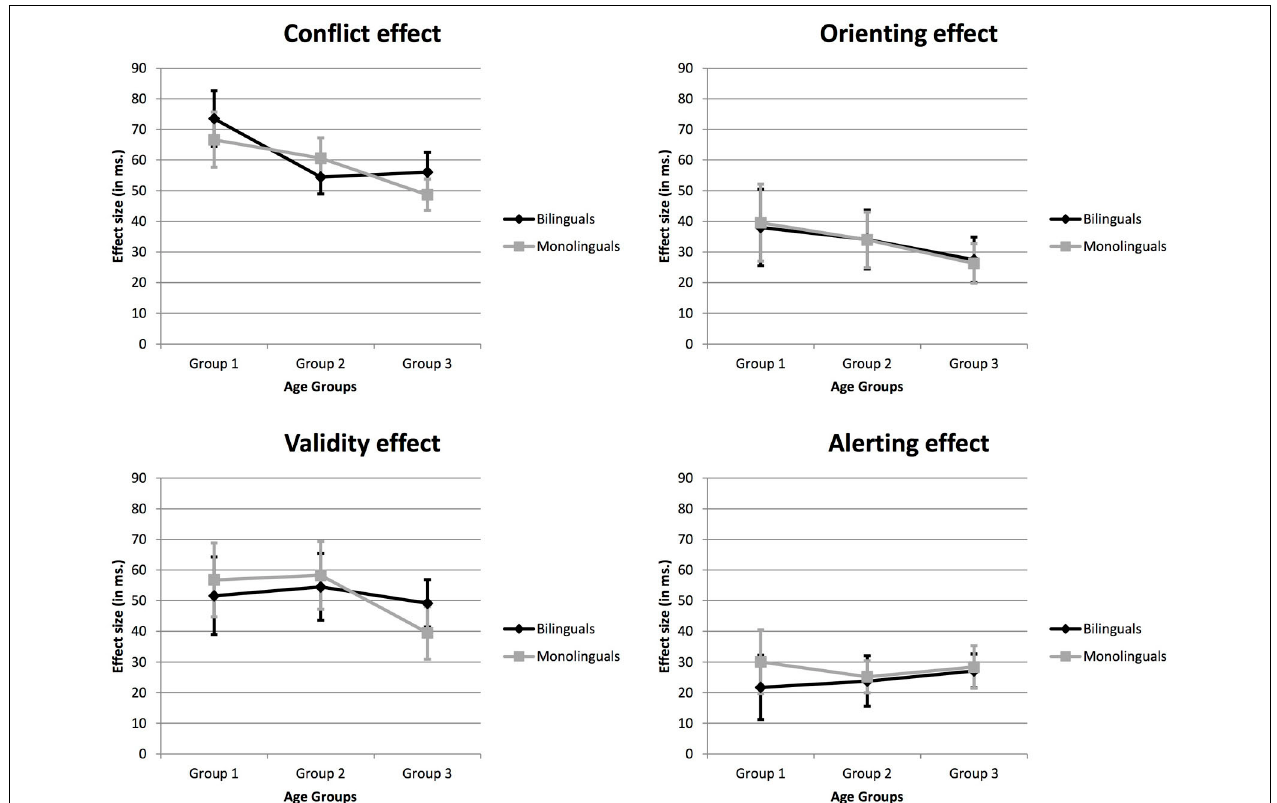
FIGURE 2 | The four indexes, representing the attentional networks, across age groups and language groups.